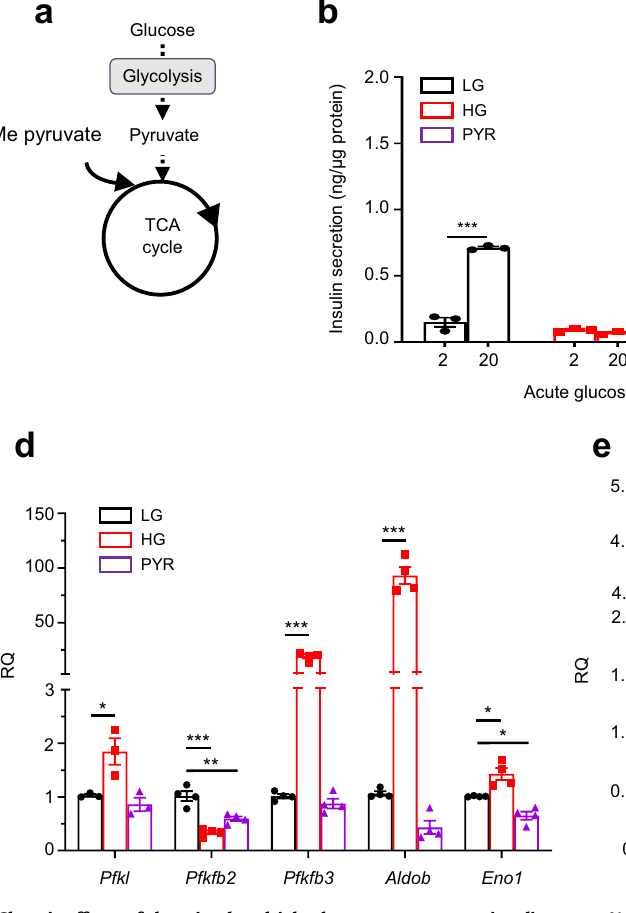
Ndufa4 and Ndufs8 , n =3 biologically independent experiments; Pfkfb2, Pfkfb3, Aldob and Eno1 , n =4 biologically independent experiments; Sdha , n =5 biologi- cally independent experiments). All panels show individual data points and mean±s.e.m.* P <0.05,** P <0.01,*** P <0.001,two-tailedunpairedStudent ’ s t test. LG-cells (black), HG-cells (red), PYR-cells (purple). Source data are provided as a Source Data fi